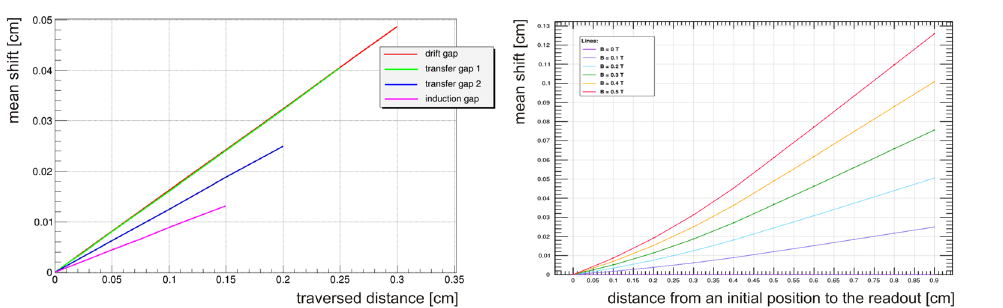
Figure 3. (Left) Dependence of the mean electron shift in the transverse drift direction on its traversed distance for all GEM gaps; (right) dependence of the mean electron shift on the distance to the readout plane for various magnetic field